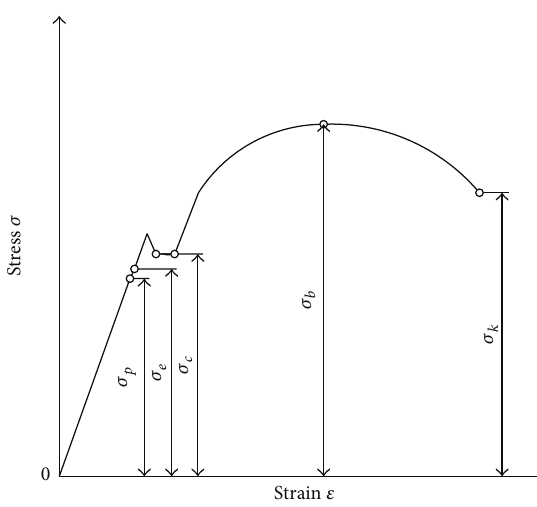
Figure 7: The curve of stress-strain.